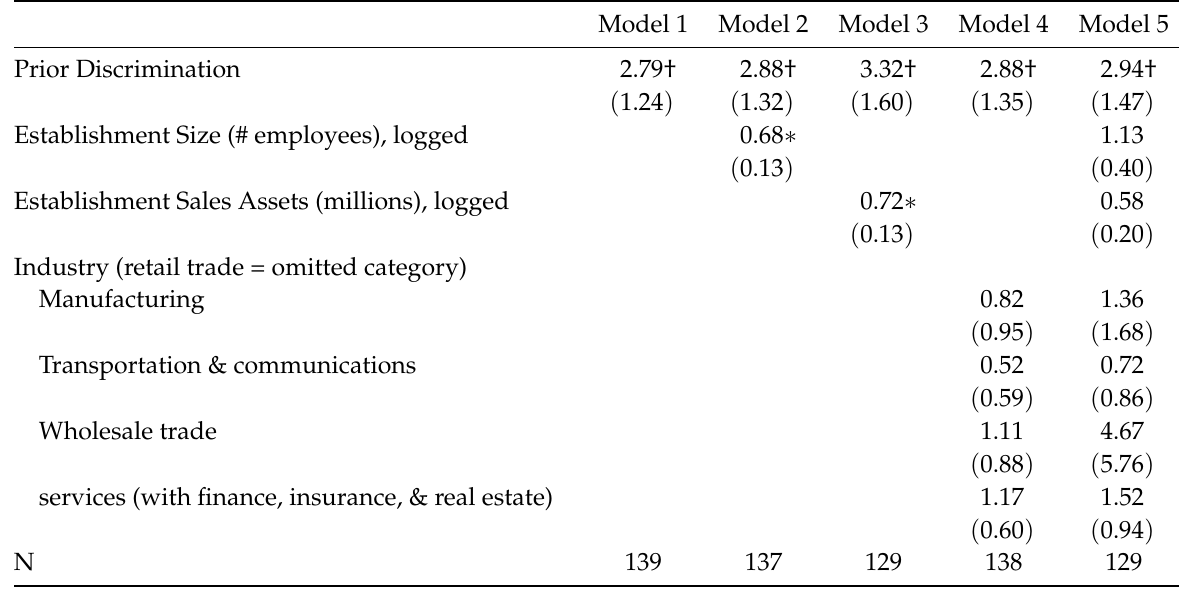
Table 1: Prior discrimination, establishment characteristics, and the odds of going out of